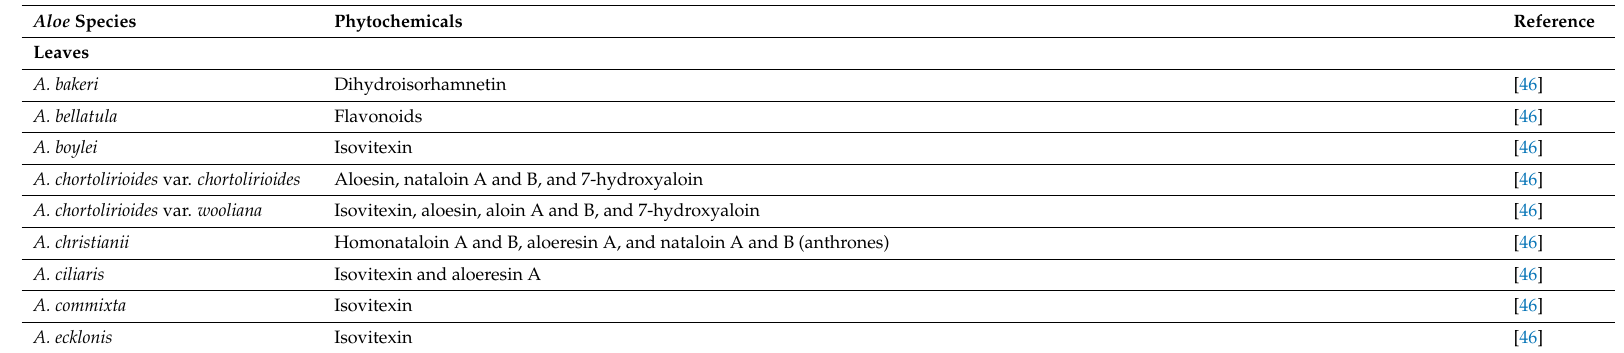
Table 3. Phytoconstituents of Aloe species detected by high-performance liquid chromatography and thin-layer chromatography